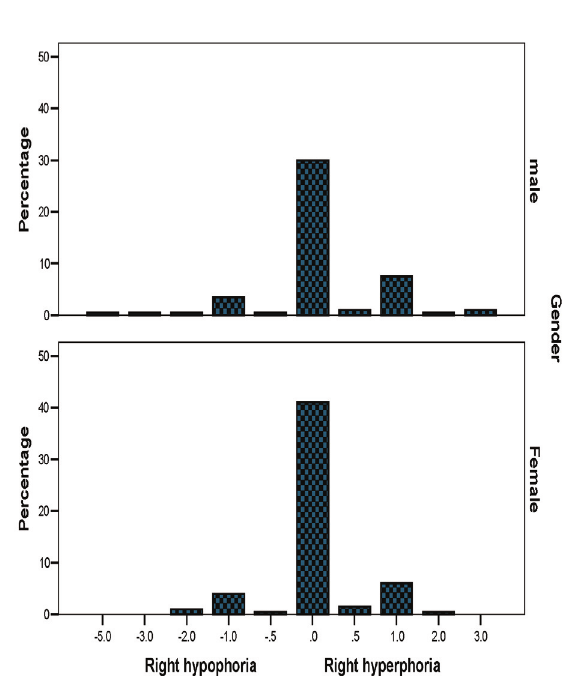
Figure 7 Distribution of distance vertical heterophoria accord- ing to gender, showing greater orthophoria for both male and female.